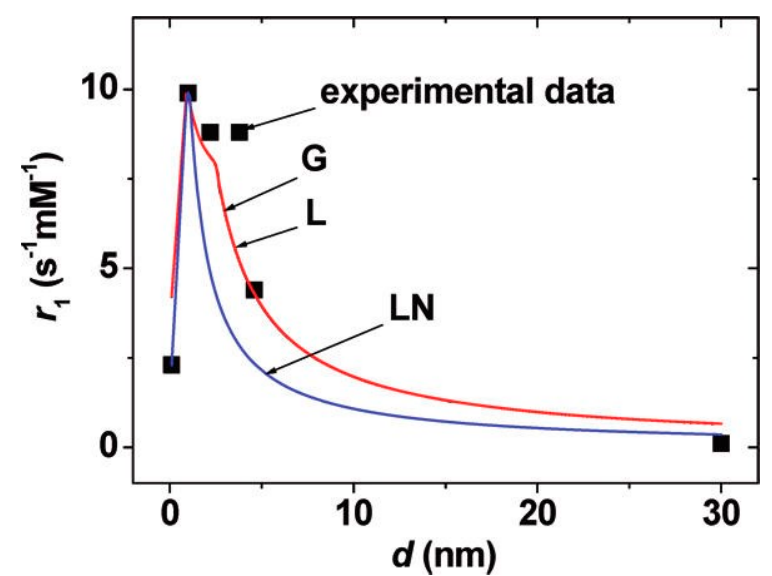
Figure 13. Reproductions of r 1 . The functions are labeled as G (Gaussian), L (Lorentzian), and LN (log-normal). Reprinted with permission from J. Y. Park, M. J. Baek, E. S. Choi, S. Woo, J. H. Kim, T. J. Kim, J. C. Jung, K. S. Chae, Y. Chang and G. H. Lee; “Paramagnetic ultrasmall gadolinium oxide